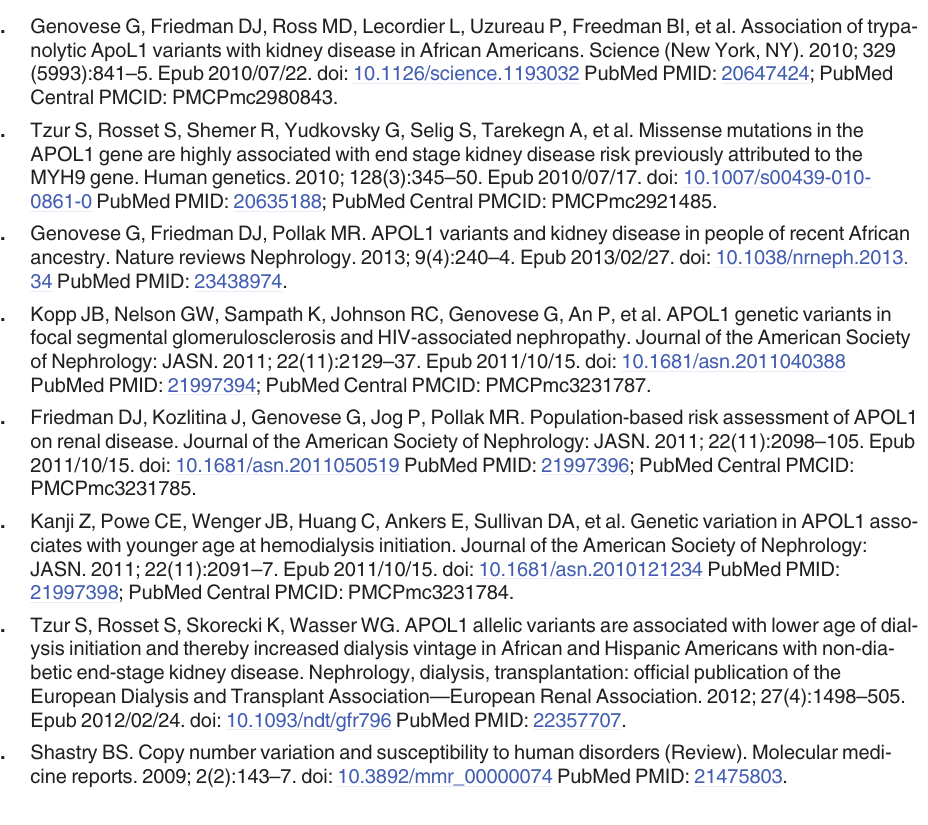
S1 Table. Sequence data. A. Sequence data for the eight 1000 Genomes project samples dis- cussed in the text is available online and accessible at the URLs listed. B. Sequence data (reads across DNA breakpoint) for the two relevant samples from our laboratory. S2 Table. APOL1 fragment amplification and subcloning study. S2 Table, top: PCR frag- ment cloning and sequencing. The table shows the number of colonies that were sequenced and determined to have genotypes G0 and G1, when genomic DNA from the lymphoblast cell lines was used as template to obtain and clone the PCR fragment. The genotype was inferred in conjunction with data from Taqman copy number assay. S2 Table, bottom: Data from a similar experiment, using fragments amplified and subcloned after RT-PCR from RNA. The genotype was inferred based on the ratio of G0 to G1